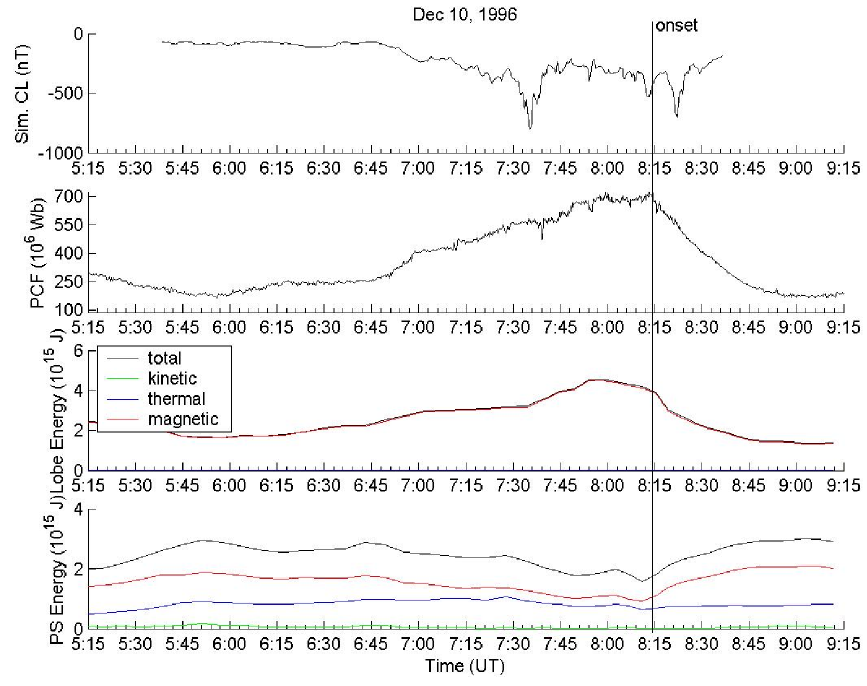
Fig. 6. Panel 1 shows the simulated CL index, panel 2 shows the polar cap flux. The evolution of total (black), kinetic (green), thermal (blue), and magnetic (red) energies in lobe and plasma sheet is seen in panels 3 and 4, respectively.